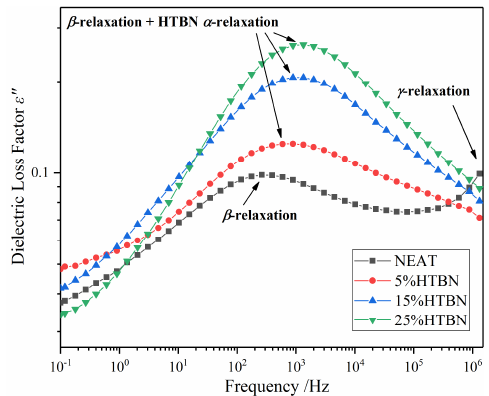
Figure 3. Frequency spectrum characteristics of dielectric loss factor with different HTBN contents at −40 °C.